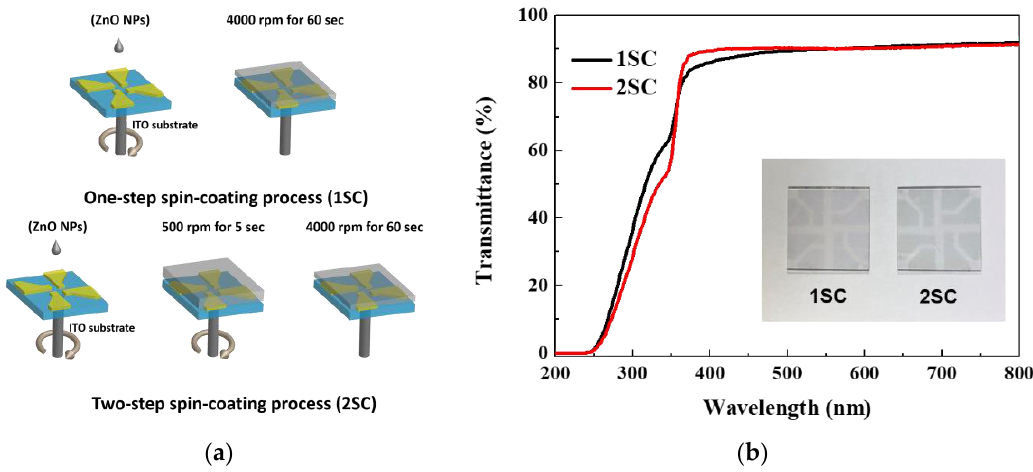
Figure 2. ( a ) Schematic description of two different spin-coating processes for the electron transport layer (ETL) using ZnO NPs and ( b ) transmittance spectra of ZnO layers on patterned ITO glass substrate.